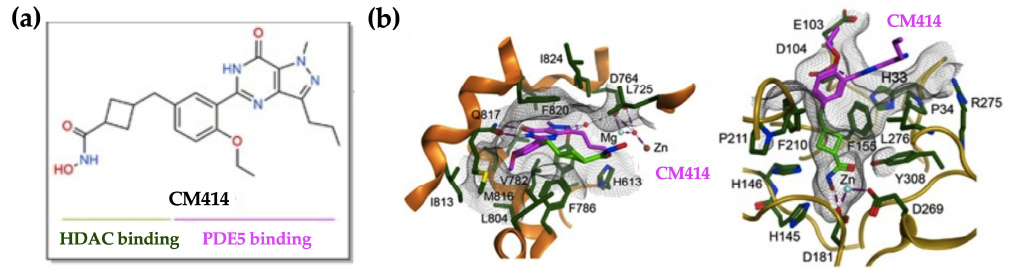
Figure 1. CM414, dual inhibitor of Class I histone deacetylases (HDACs) and phosphodiesterase 5 (PDE5). ( a ) CM414 chemical formula highlighting the hydroxamic moiety that interacts with HDACs and the pyrazolopyrimidinone core that interacts with PDE5. ( b ) representations of CM414 bound to PDE5 (left panel) and HDAC2 (right panel).